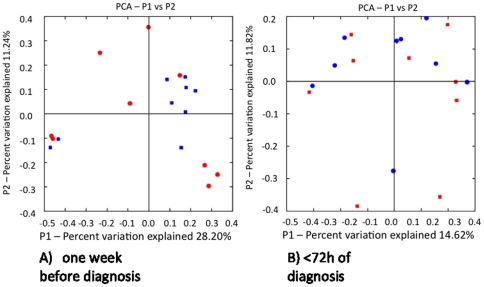
Unifrac diversity measures.Principal component analysis (PCA) of overall diversity based on UniFrac (unweighted) metric A) one week before and B) within 72 hours of NEC diagnosis. Squares represent controls and circles represent cases. P1 is component 1 and P2 component 2.